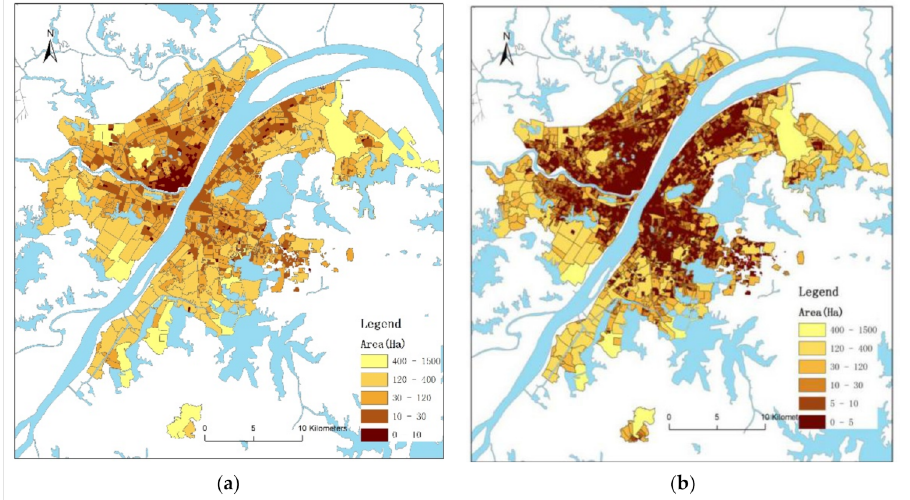
Figure 5. Spatial distribution of community and basic grids: ( a ) Distribution of community; ( b ) Dis- tribution of basic geographical grids.